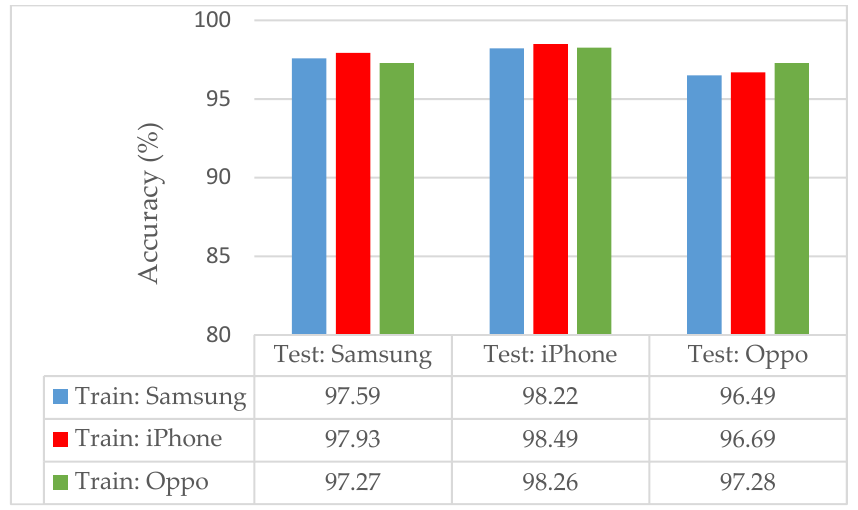
Figure 12. The performance of LDA-CNN model on cross-sensor experiments using VISOB dataset.